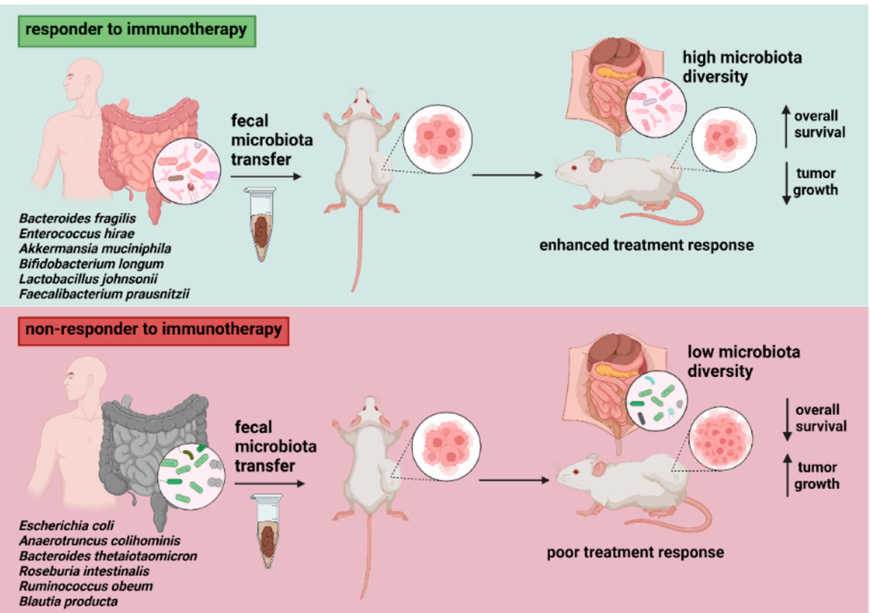
Figure 3. The impact of fecal transfer from responders vs. non-responders on immunotherapy effi- cacy in tumor-bearing murine models. Cancer patient to mouse models transfer reported improved response to treatment with immune checkpoint inhibitors after FMT from responders, documented by retarded tumor growth and immune activation by elevated levels of CD8 + T cells. Donor microbiota enriched by particular bacterial species (most reported are listed) might contribute to microbial alter- ations in recipient animals, determining the overall treatment effect. Discrepancies related to several bacterial taxa (e.g., Ruminococcaceae ) showing abundance in both responder and non-responder donor samples suggest the existence of more complex and patient-dependent host–microbiome